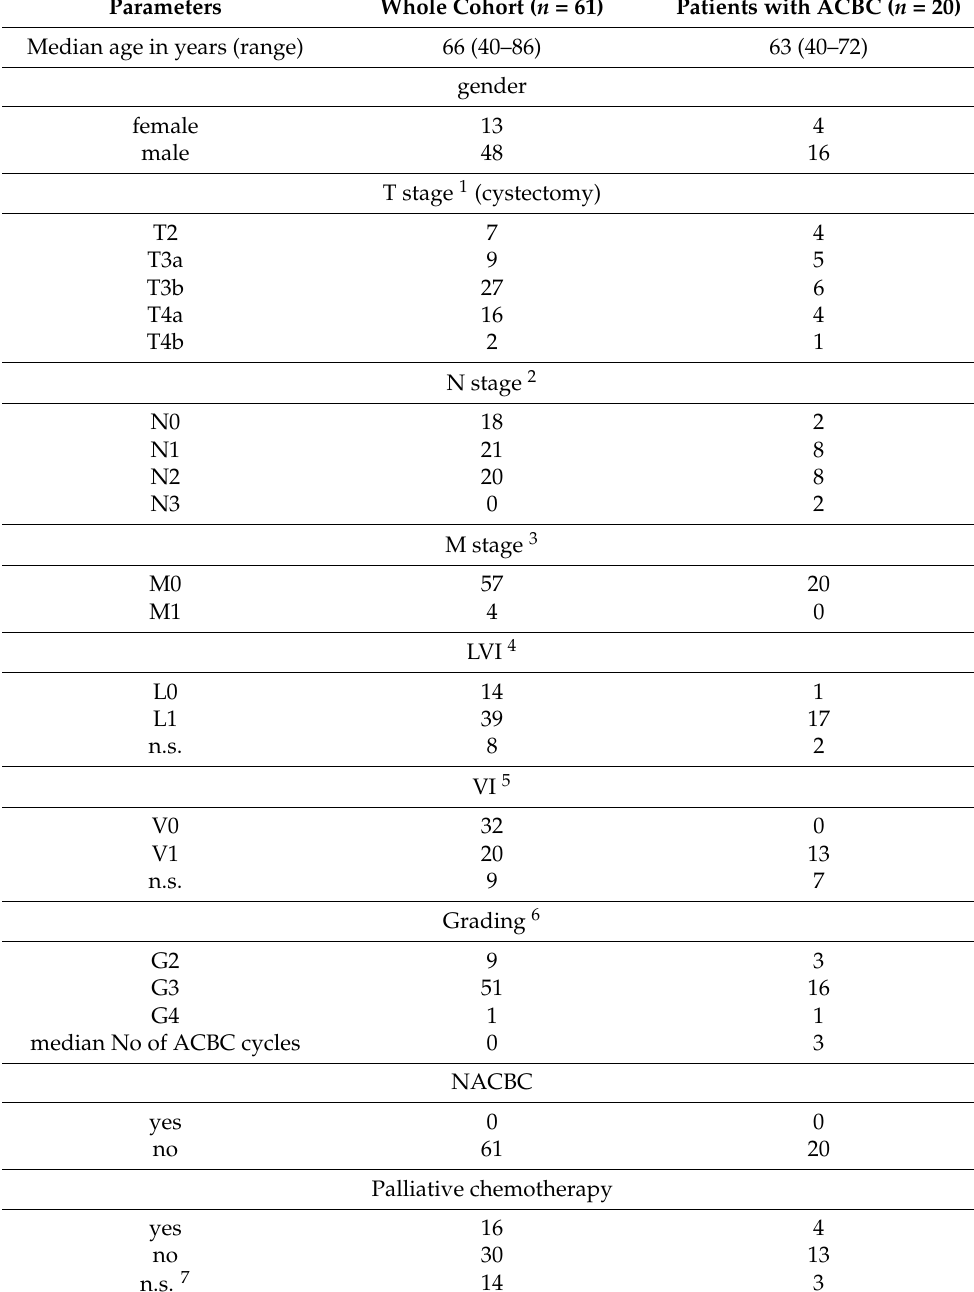
Table 1. Patient characteristics of the Mannheim